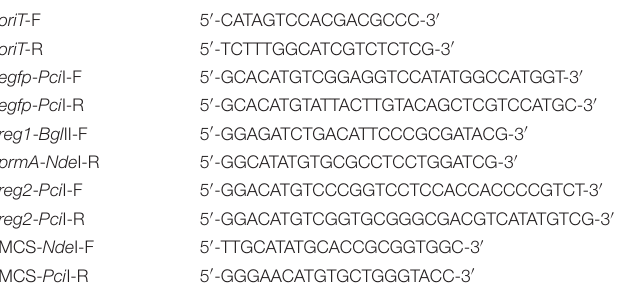
TABLE 1 | List of primers used in PCR.